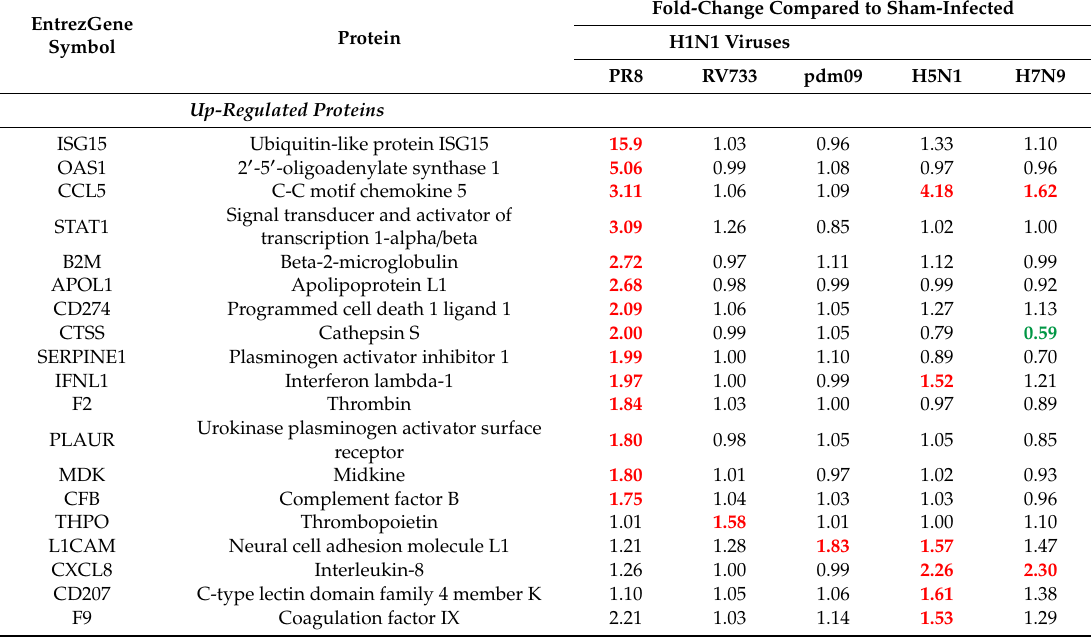
Table 2. A549 proteins dysregulated by infection by indicated influenza strains. EntrezGene